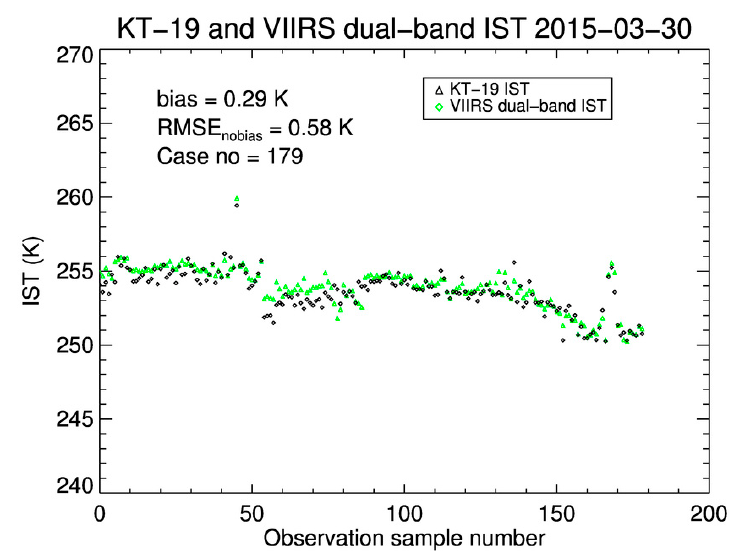
Figure 6. KT-19 ice surface temperature (IST) (black) and dual-band IST from S-NPP VIIRS (green) along the P-3 Ice Bridge flight track around 22:17 UTC on 30 March 2015.